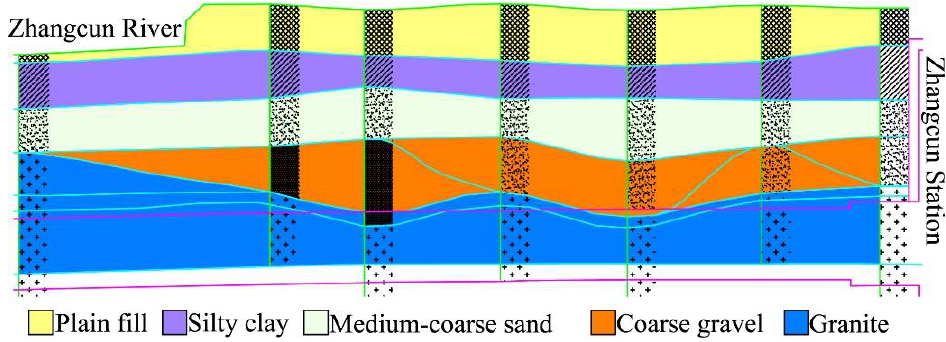
Figure 1. Geological profile of the receiving terminal.